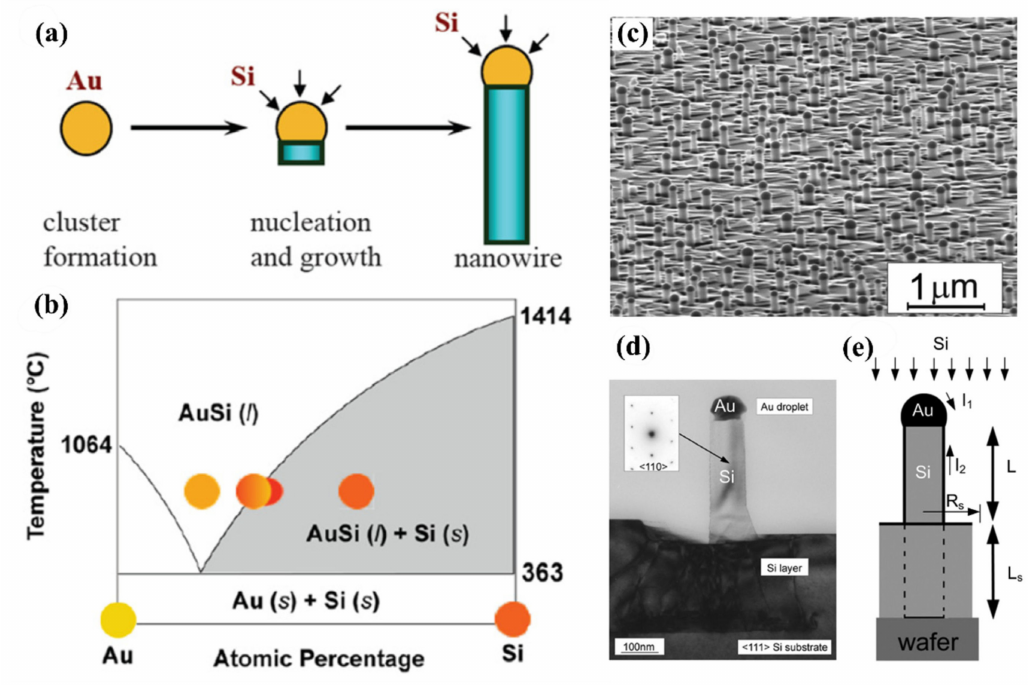
Figure 3. Schematic of CVD-VLS growth of SiNWs. ( a ) A liquid alloy droplet Au-Si is first formed above the eutectic temperature (363 ◦ C) of Au and Si. The continuous feeding of Si in the vapor phase into the droplet causes supersaturation of the liquid alloy, resulting in nucleation and growth of SiNWs. ( b ) Binary phase diagram for Au and Si showing the thermodynamics of CVD-VLS growth. Reproduced from [101], with permission from IOP Publishing, 2020. ( c ) SEM images of SiNWs grown on a (cid:60) 111 (cid:62) Si substrate at 525 ◦ C for 120 min by MBE. ( d ) TEM cross section image of a SiNW with Au on top. ( e ) Schematic representation of the MBE NW growth. I1 and I2 are fluxes of Si adatoms directed to the gold cap. Reproduced from [102], with permission from American Vacuum Society,